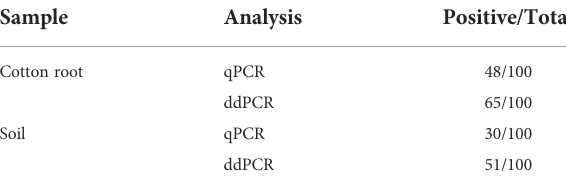
TABLE 2 Performance of qPCR and ddPCR assays using Vdl-1 primers to detect V. dahliae and V. longisporum in DNA extracted from cotton root and soil